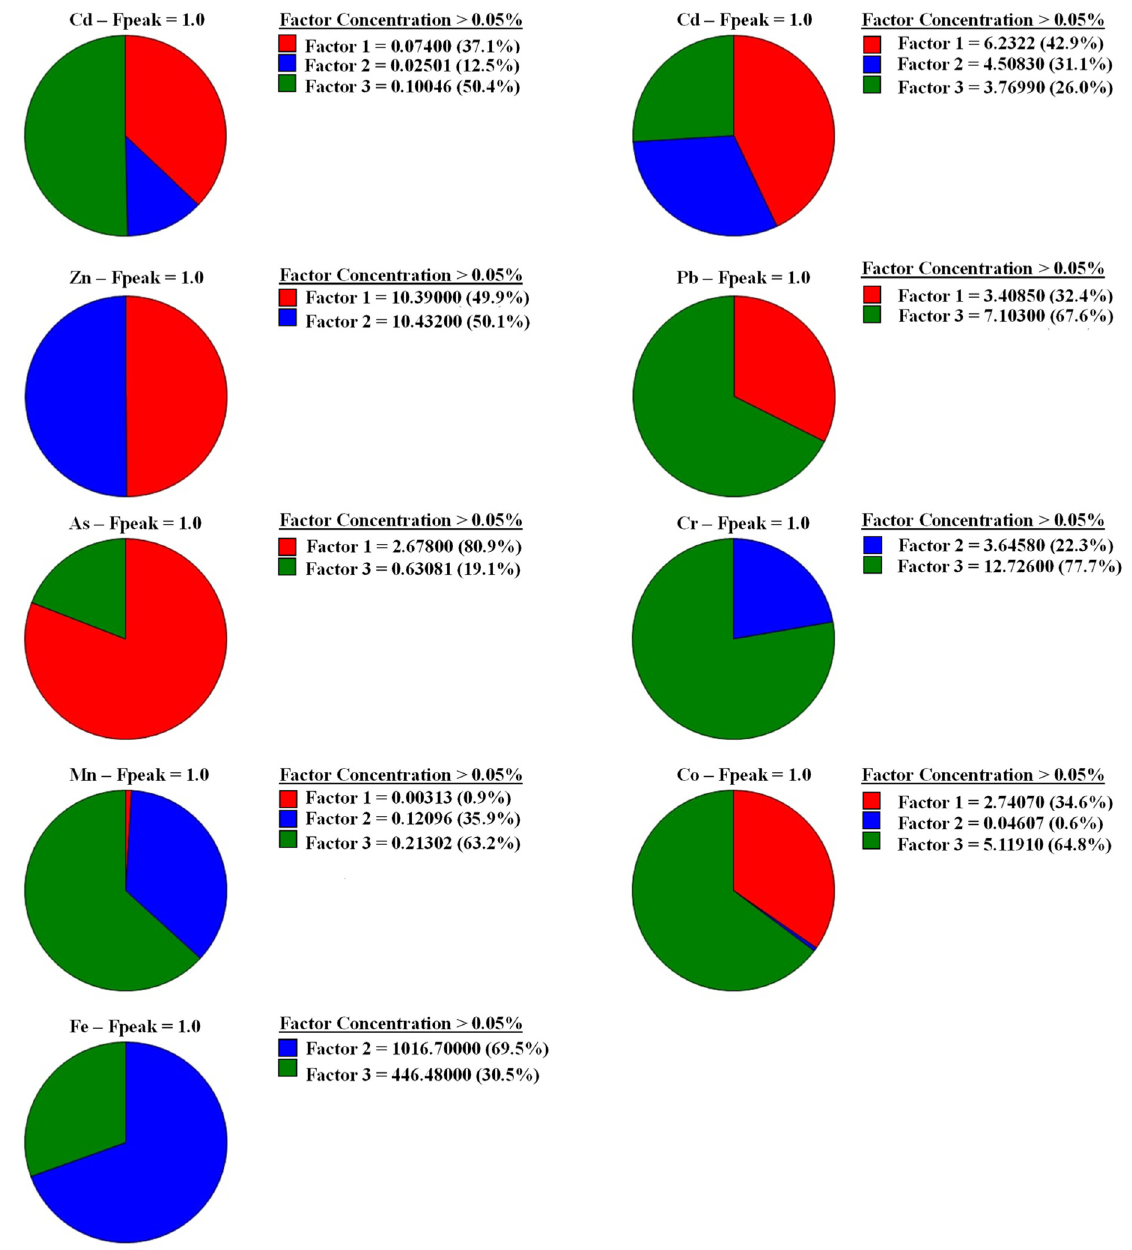
Figure 7. Factor contribution of heavy metal contamination in the sediment from the PMF model. According to the ER and PER results, the Cd contamination in the sediment revealed the highest risk condition, revealing an increased accumulation of Cd in the sediment. From the PMF model, the sources of Cd contamination in the reservoir were from all three factors. The contribution percentage of Cd contamination is ranked as follows: factor 3 (50.4%) > factor 1 (37.1%) > factor 2 (12.5%). Significant sources of Cd contamination are likely from urban activities, such as the burning of plastic wastes, open dumping of electronic waste and other Cd-containing solid waste (e.g., empty bottles of pesticides, herbicides, fungicides, and phosphate fertilizers, etc.), and direct discharge of wastewater from municipalities (e.g., households, barber and salon, motorcycle repair shops, waste sorting, and recycling shops)